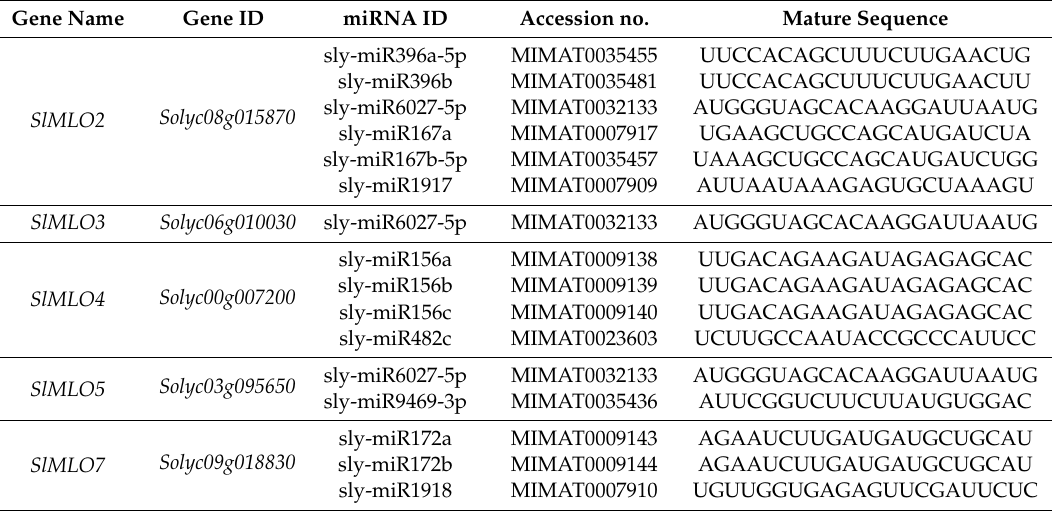
Table 5. Predicted miRNAs targeting SlMLO genes in tomato.